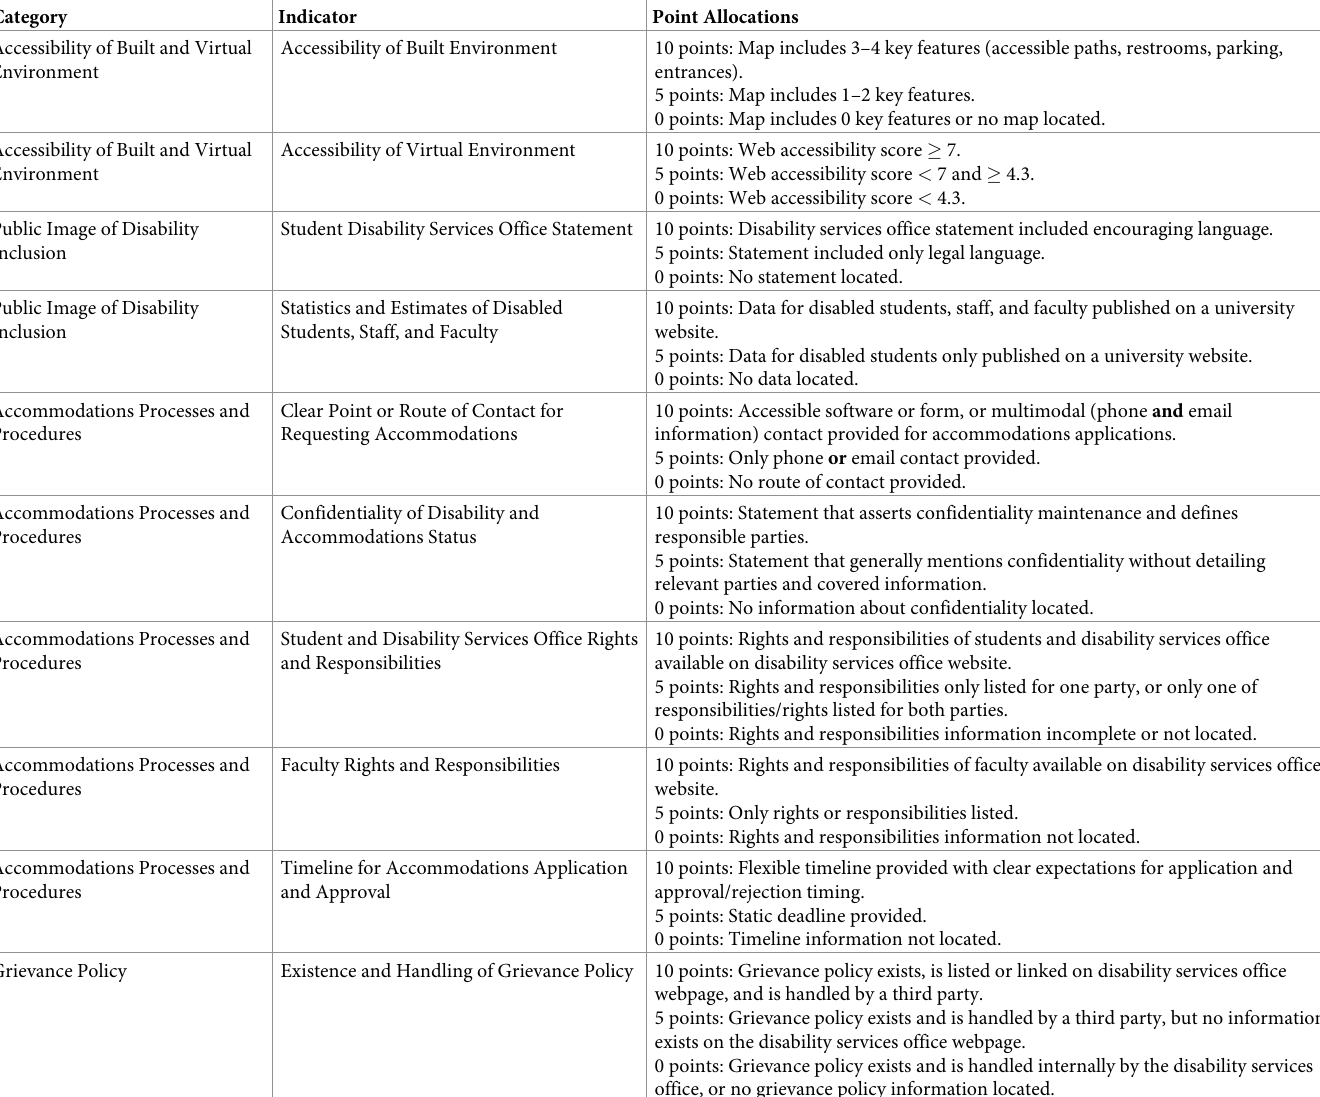
Table 1. Summary of University Disability Inclusion Score categories, indicators, and point